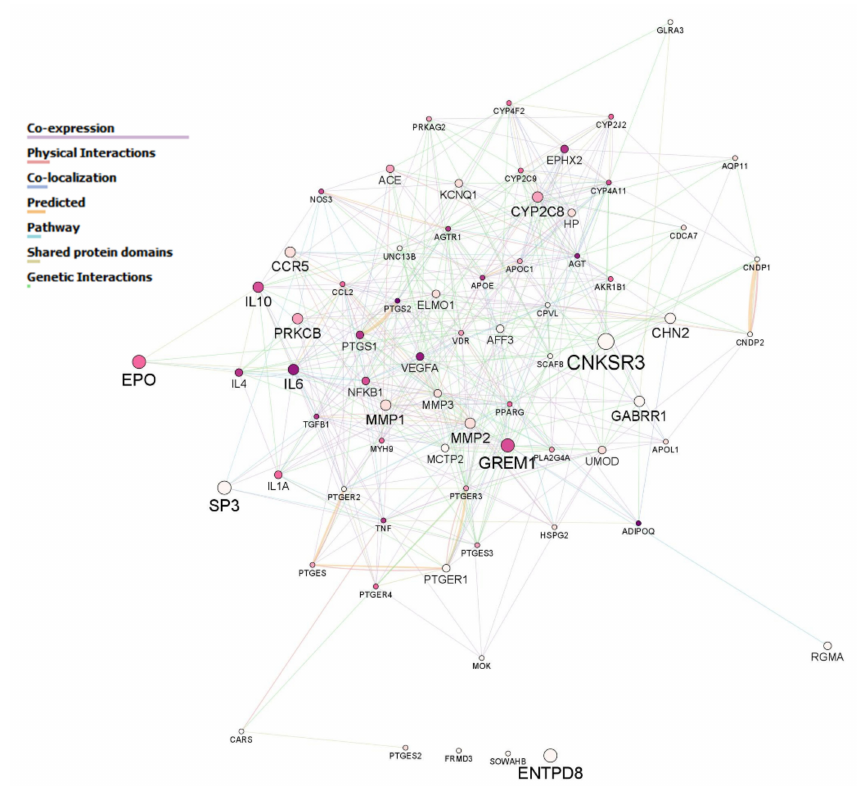
Figure 3. Candidate genes included in the study. The size of each node (gene) corresponds with the number of variants harbored in the gene locus, whose frequencies were significantly different between controls and patients. The more variants, the larger the size. The color of the node corresponds to the number of major biological pathways in which the gene participates; the darker the color, the more pathways are involved. White nodes represent genes that did not participate in any of the most common biological routes observed for the 70 genes according to the GO annotation for biological processes. The different color-coded interactions are specified in the